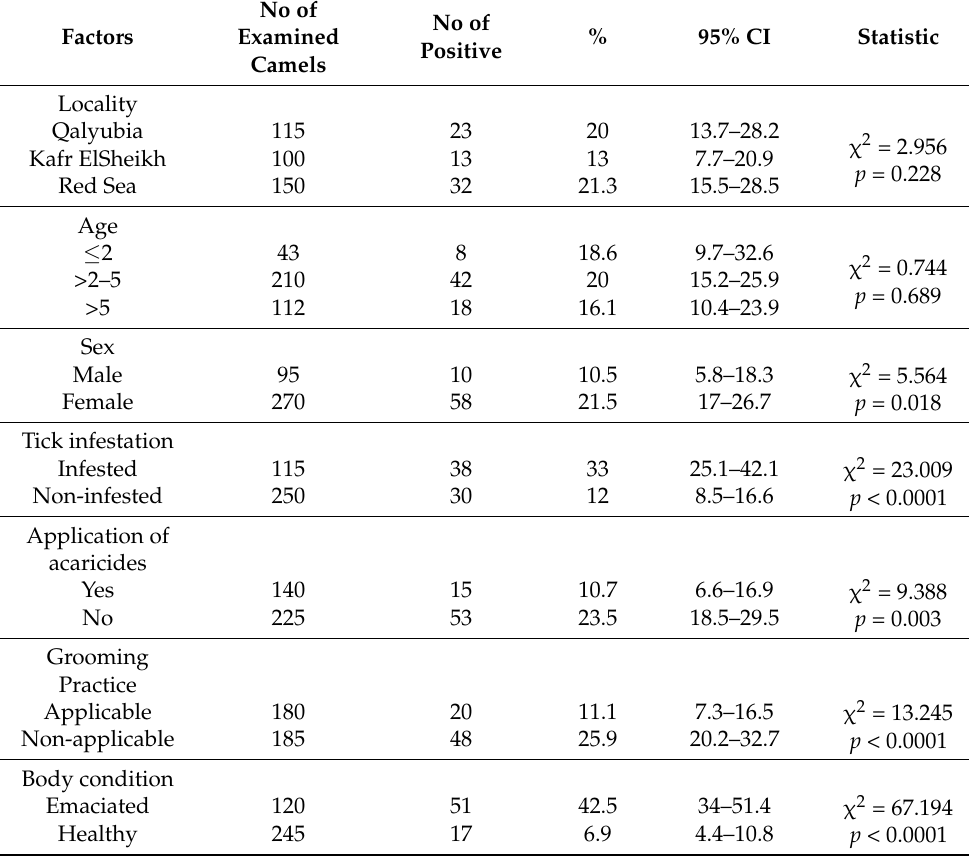
Table 1. Risk factors associated with Anaplasma spp. infection in camels.